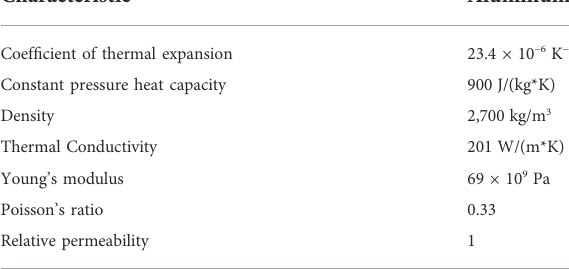
TABLE 2 Physical properties of aluminum